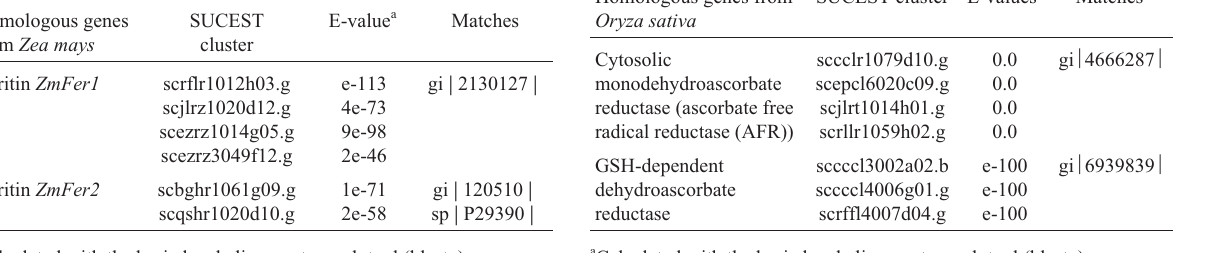
Table I - Ferritin homologues found in the SUCEST database. Homologous genes from Zea